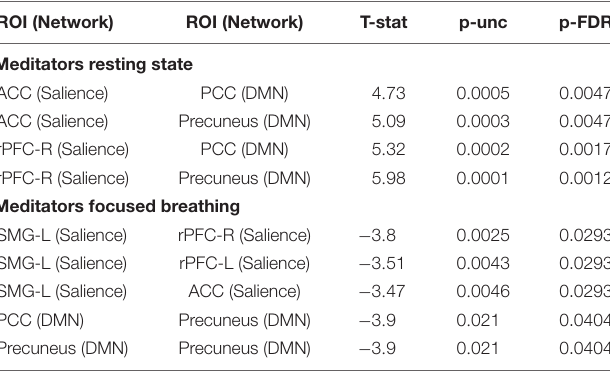
Samyama program. ROI (Network)